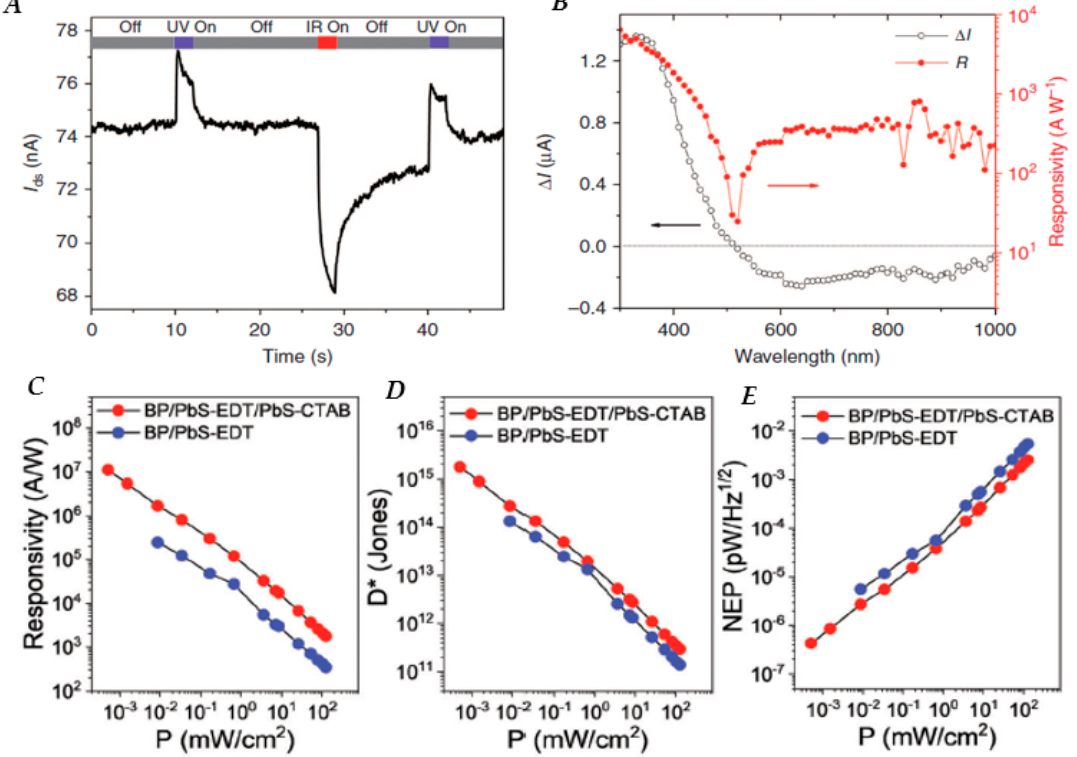
Figure 7. ( A ) Photocurrent as a function of time under illumination with 365 and 970 nm light-emitting diode (LED) light sources, showing the spectrally distinctive characteristics of the tin disulfide (SnS 2 )/PbS QD photodetector . ( B ) Wavelength-dependent photocurrent and responsivity of a SnS 2 /PbS QD device; the light source is a xenon lamp modulated with an optical grating to generate monochromatic light with a step-size of 10 nm ( V G = 0 V, V DS = 1 V). ( C ) Responsivity, ( D ) Detectivtiy and ( E ) noise equivalent power (NEP) of hybrid black phosphorous (BP)/PbS QD devices with EDT only and EDT/cetyltrimethylammonium bromide (CTAB) ligand combinations as a function of power intensity at 633 nm wavelength at V DS = 1 V and V G = 0 V. Figure ( A , B ) reproduced with permission from [150]. Copyright Springer Nature, 2016. Figure ( C – E ) reproduced with permission from [153]. Copyright Royal Chemical Society, 2019.